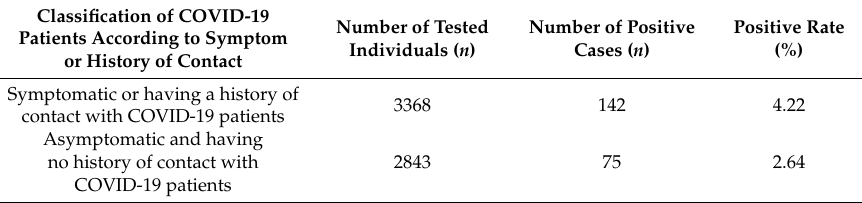
Table 2. The number of positive SARS-CoV-2 cases and positive rate according to the presence of symptoms and history of contact with coronavirus disease 2019 (COVID-19) patients. Classification of COVID-19 Number of Tested Number of Positive Patients According to Symptom Individuals ( n ) Cases ( n ) or History of Contact